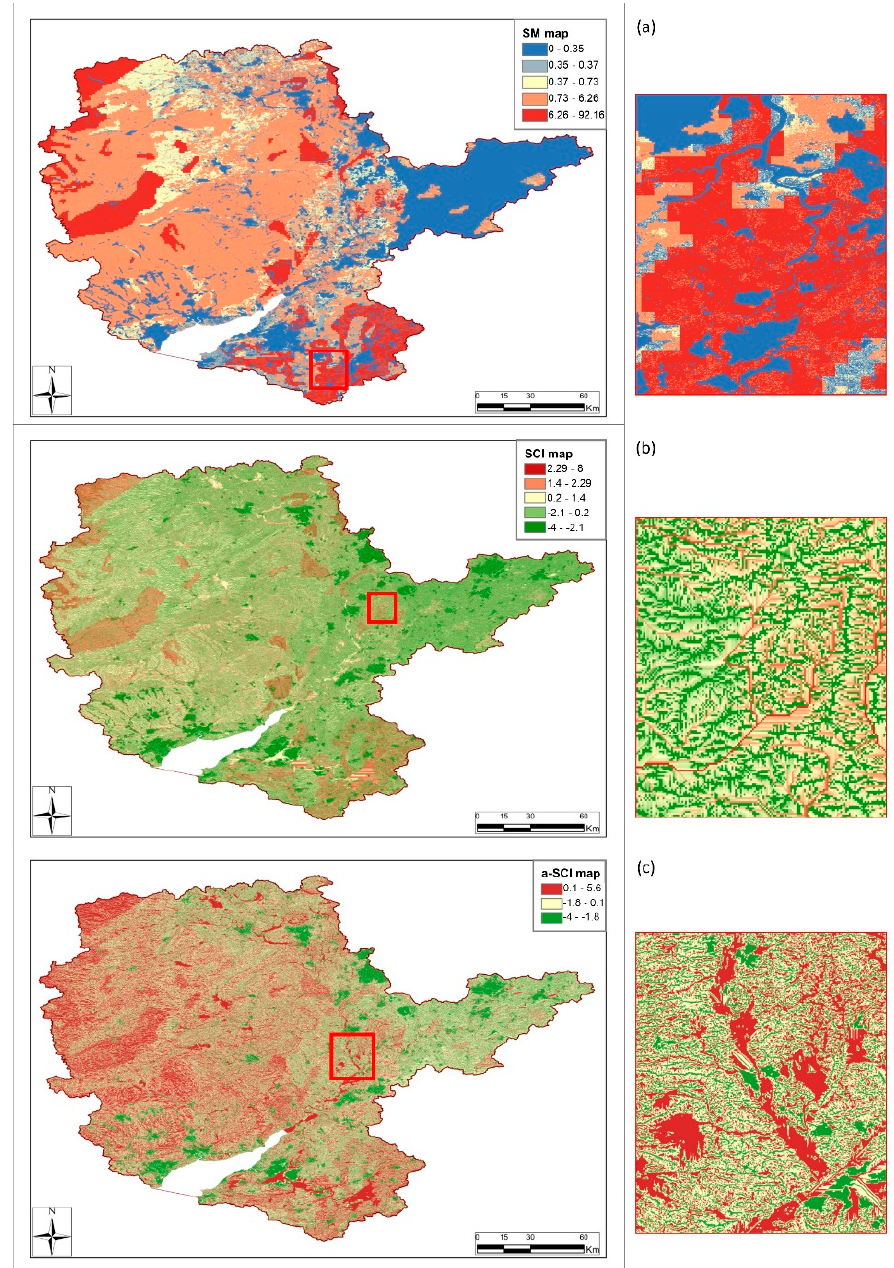
Figure 3. ( a ) Sediment mobility (SM) map (obtained from Equations (1)–(3)); ( b ) sediment flow connectivity index (SCI) map, and ( c ) a-SCI map of the Severn catchment. The detail maps on the right of each map correspond to the respective red boxes on the maps on the left, highlighting different areas of the catchment chosen to better illustrate the small scale characteristics of each index.